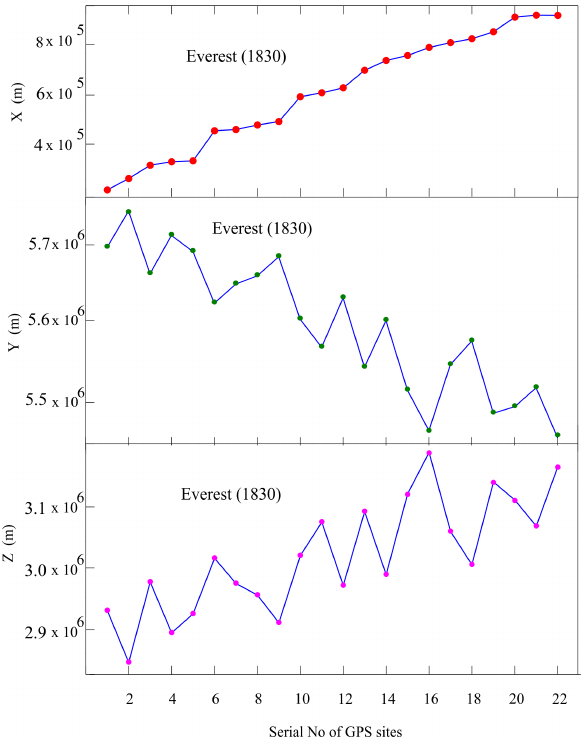
Figure 3: Training data for Everest (1830) datum (in X, Y and Z) coor- dinates and ANN prediction